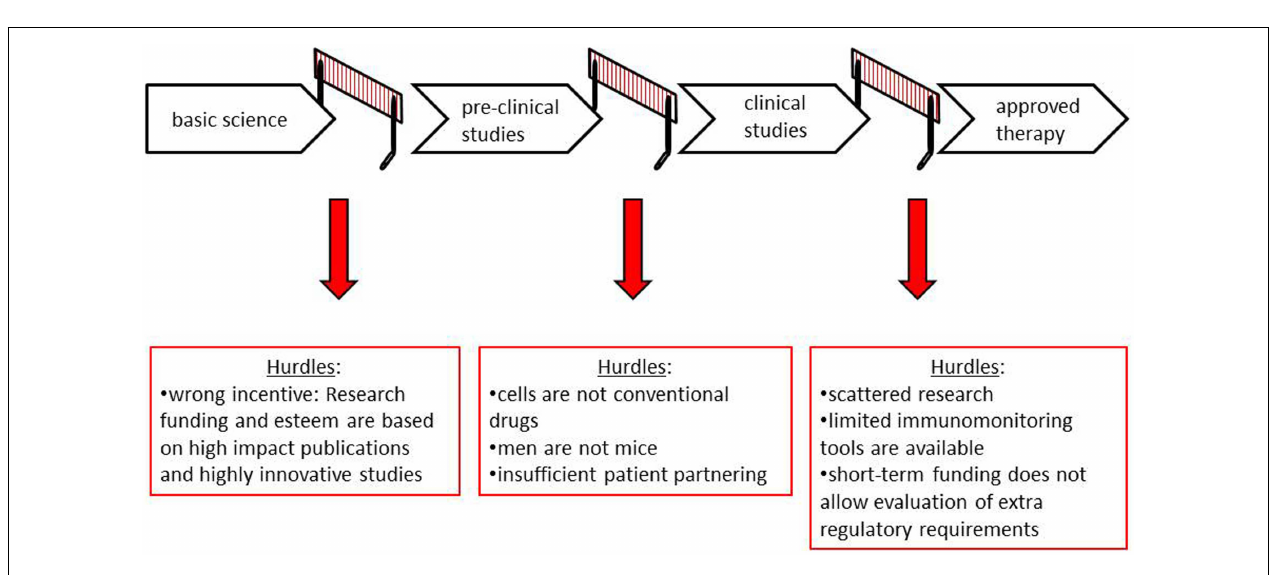
FIGURE 1 | Steps and hurdles in clinical translation of tolerance-inducing cellular therapies .